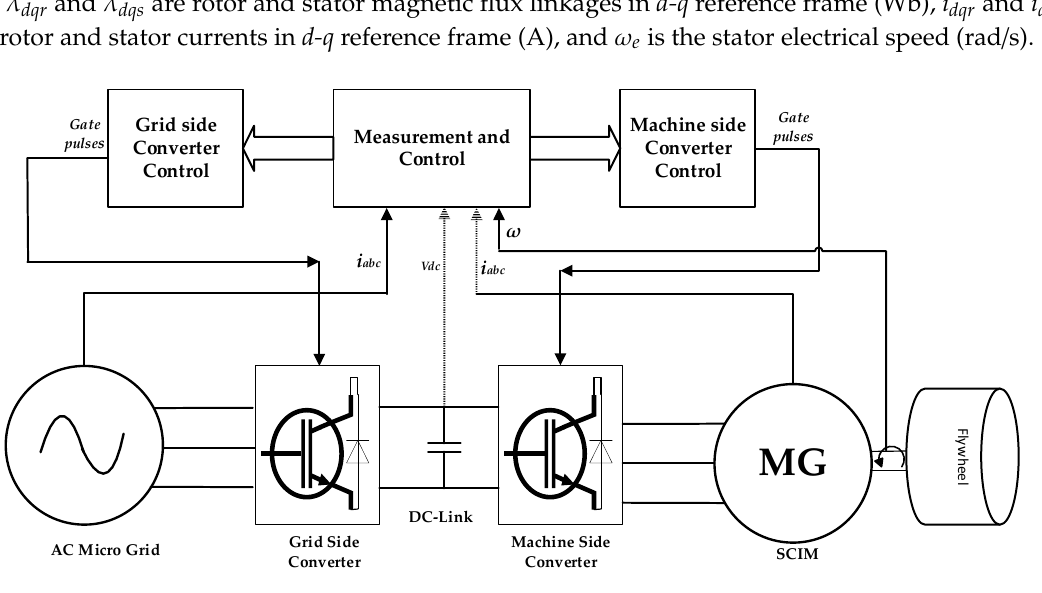
Figure 3. Schematic diagram of FESS.